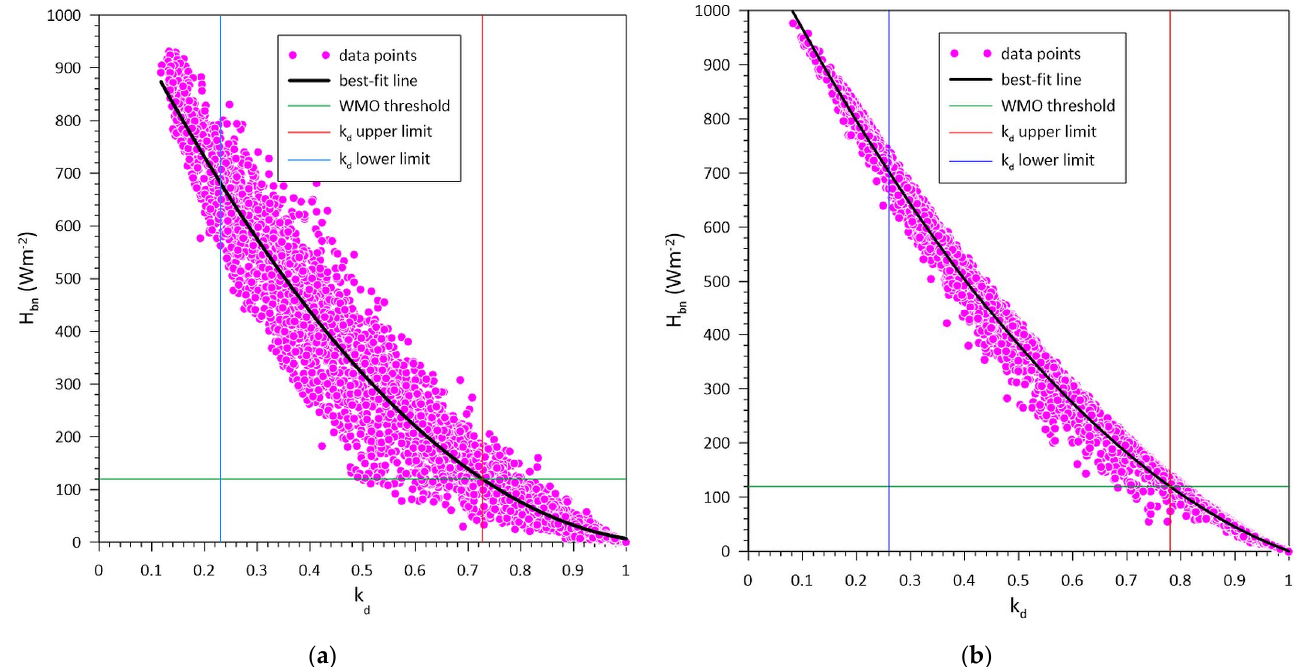
Figure 8. Determination of the k du (red line) and k dl (blue line) values for the ( a ) LER and ( b ) LIN sites.